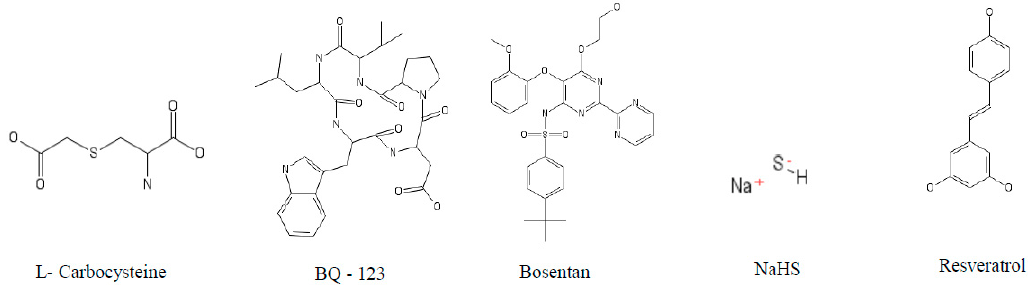
Figure 4. Structure of different cysteine protease inhibitors tested against COPD models.